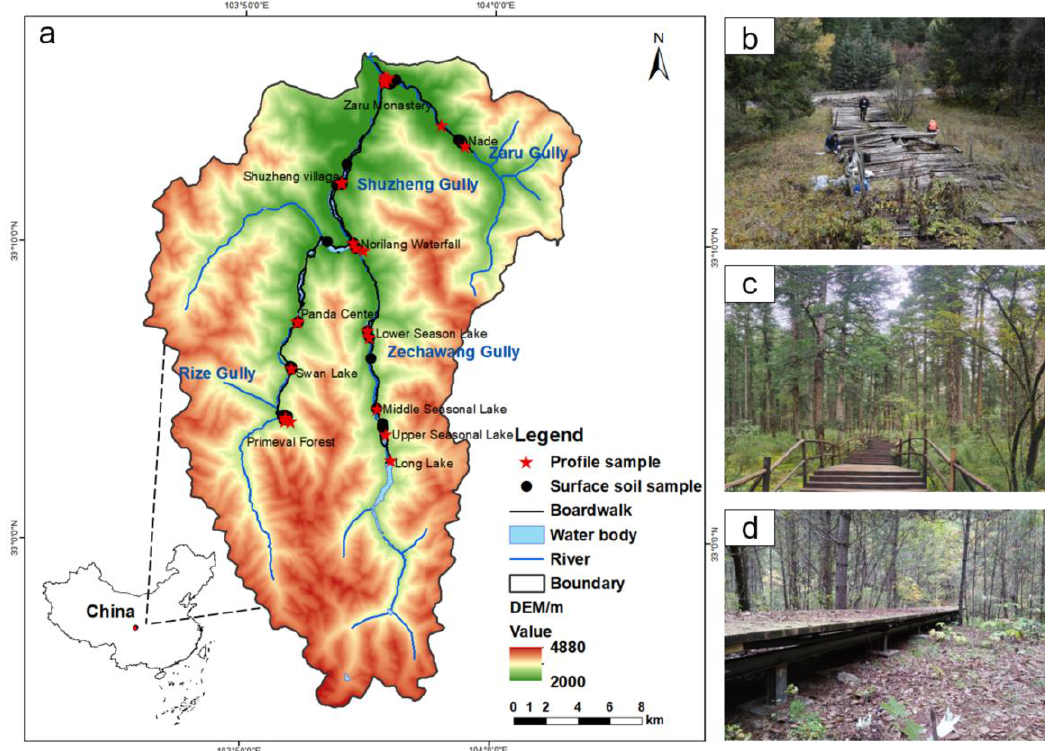
Figure 1. Distribution of boardwalks treated with wood preservatives ( a ) and sampling sites ( b ), CCA treatment, Panda Center; ( c ), ACQ treatment, Primeval Forest; ( d ), CA treatment, Zaru Monastery) in the Jiuzhaigou National Natural Reserve, Southwest China.